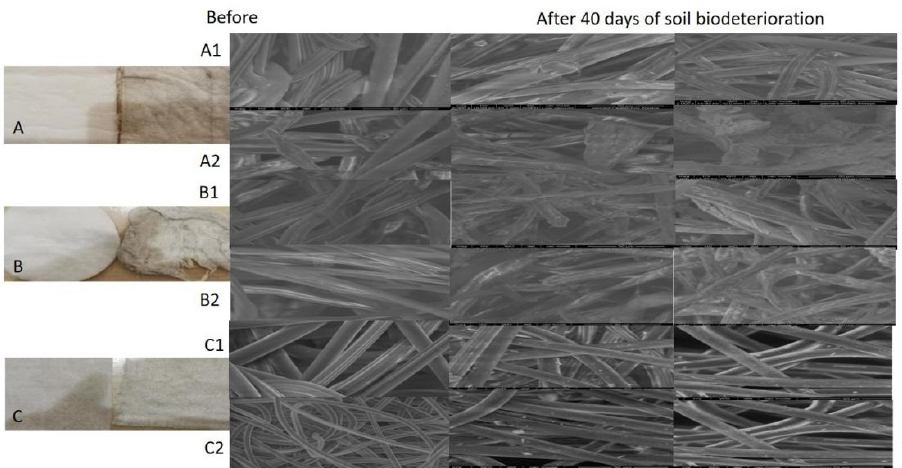
Figure 3. Biodeterioration of disposable hygiene and sanitary PCPs, two different brands (named 1 and 2) of sanitary pads ( A ), cosmetic pads ( B ) and wet wipes ( C ) in soil #1 from Ceatalchioi. Material morphology changes were observed using stereomicroscope (right images) and scanning electron microscopy (2000 × ) (left